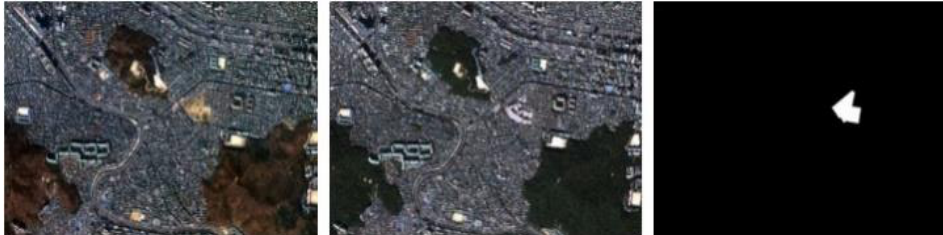
Figure 8. Test area 2 (3232 × 2206): ( left ) Image P, acquired in March 2014; ( middle ) Image C, acquired in October 2015; ( right ) Ground truth.